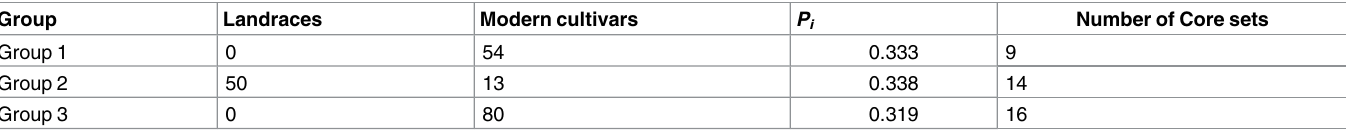
Table 2. Comparison between the model-based